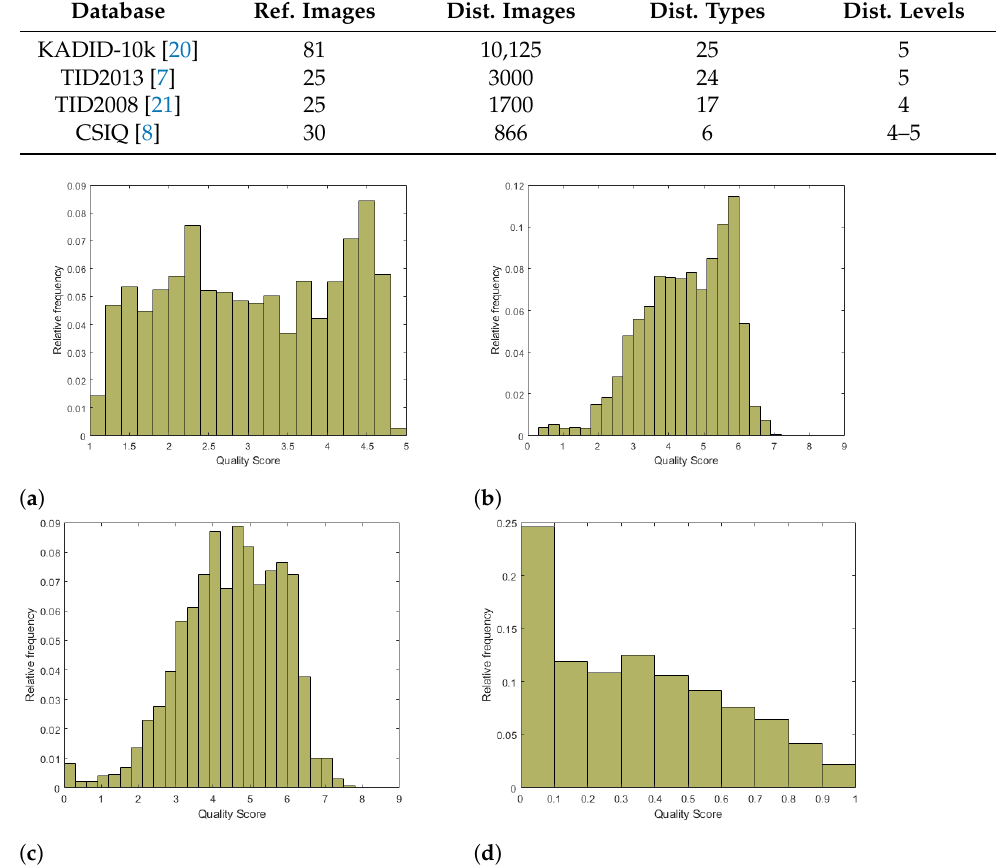
Figure 2. Empirical MOS distributions in benchmark IQA databases: ( a ) KADID-10k [20], ( b ) TID2013 [7], ( c ) TID2008 [21], and ( d ) CSIQ